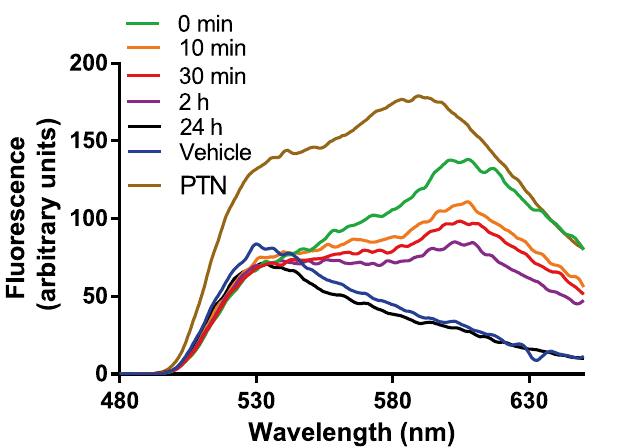
Figure 5. PTN penetration into the tumour. SOT was topically applied with 1.96 mg of PTN in DMSO. After 2 h, tumours were excised, and fluorescence of fresh sections was visualized by fluorescence microscopy. The basal superficial section of the skin (upper plane) and the deeper region (mid-plane) were documented at × 10. Controls treated with DMSO were included.